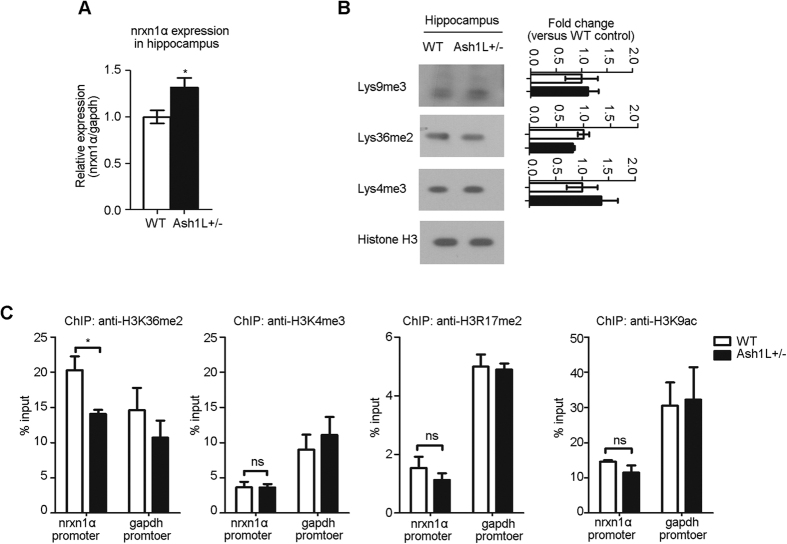
Increased nrxn1 expression and reduced H3K36me2 at the nrxn1α promoter in the hippocampus of Ash1L (−/+) mice.(A) Real-time PCR showed up-regulation of nrxn1α mRNA in the hippocampus of Ash1L (−/+) mice aged 3 months (n = 4 each group). (B) Samples from the hippocampus showed no changes in histone methylation levels in Ash1L (−/+) mice (full-length blots in Fig. S6; n = 3 each group). (C) ChIP was performed on the nrxn1α promoter using antibodies for H3K36me2, H3K4me3, H3R17me2 and H3K9ac in the hippocampus of wild-type and Ash1L (−/+) mice aged 3–4 months (n = 3). Student’s t-test, *P < 0.05.